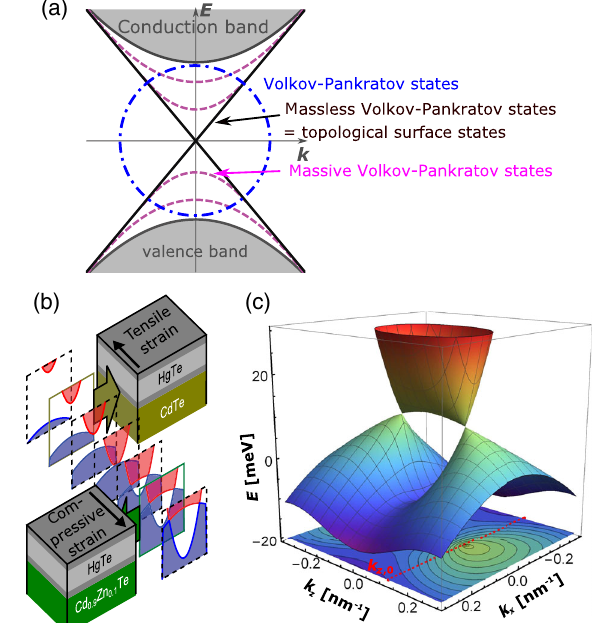
FIG. 1. Panel (a) shows a schematic picture of the band structure at an interface of two semiconductor materials with mutually inverted bulk bands (gray) with two types of interface states (named after the authors of Ref. [6] Volkov-Pankratov states), the massless interface states in black and the massive ones in dashed magenta. (b) Strain-imposed growth of HgTe. Tensile strain is realized by a CdTe substrate, compressive strain by a Cd 0 Zn 0 Te virtual substrate. Plotted as a function of k z , i.e., . 9 . 1 along the growth direction, the band structure profile changes from quadratic band touching for unstrained HgTe to a topo- logical bulk gap for tensile strain and a pair of linear level crossing for compressive strain. (c) Band structure plot for the compressive strain regime in the k z - k x momentum plane. The bulk inversion asymmetry that would split the Dirac points into Weyl nodes is not accounted for in the